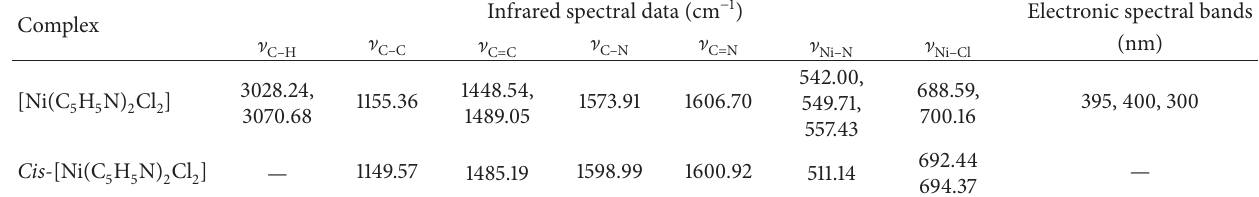
Table 2: Infrared and electronic spectral data for the complex.